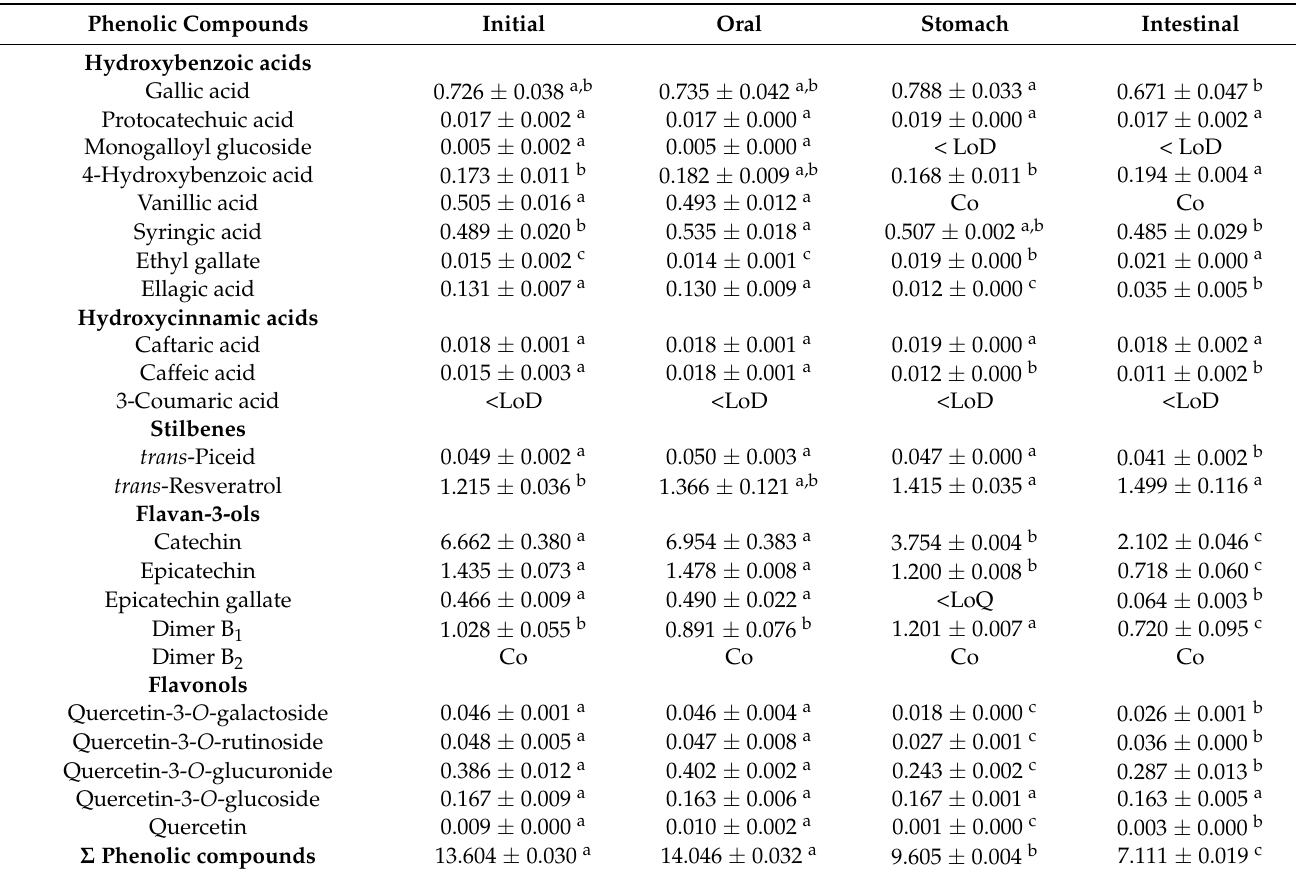
Table 4. Individual phenolic composition (monomers and oligomers) of LPE during a simulated digestion process (mg compound/g